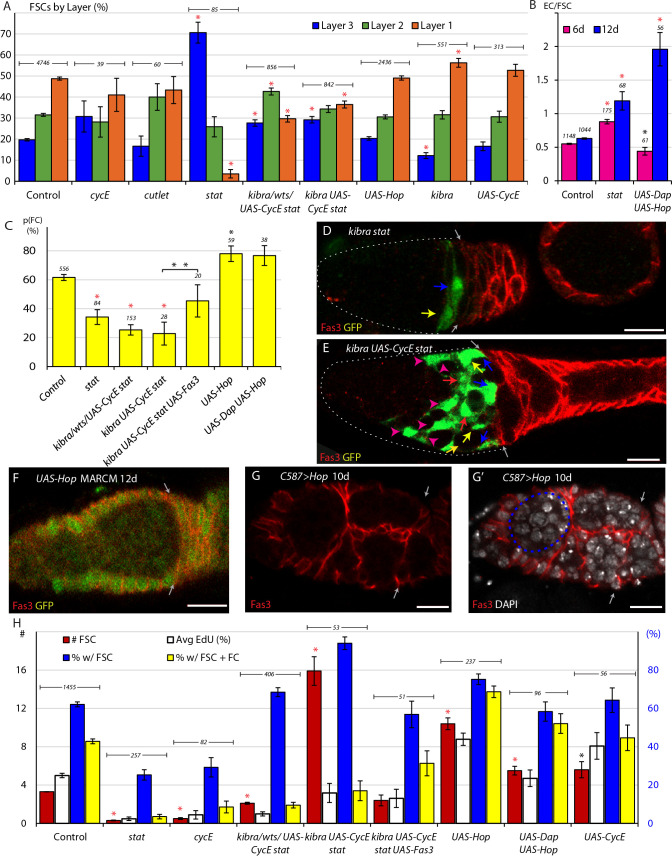
JAK-STAT signaling promotes conversion of FSCs to FCs.(A) Relative frequency of marked FSCs in each layer for the indicated genotypes of MARCM lineages, with the number of total FSCs scored for each genotype and significant differences to control values (red asterisks, p<0.001). Here and elsewhere, ‘kibra/wts/UAS-CycE stat’ is the sum of all tests with kibra stat, wts stat and UAS-CycE stat. (B) ECs produced per anterior FSC from 0-6d (magenta) and 0-12d (blue) for the indicated MARCM lineage genotypes with the total number of relevant germaria scored and significant differences to control values (black asterisk, p<0.05, red asterisks, p<0.001). (C) Average probability of a layer 1 FSC becoming an FC during a single budding cycle for the indicated MARCM lineage genotypes with the number of informative germaria scored and significant differences to control values, or for the bracketed comparison (double asterisks) showing the impact of UAS-Fas3 (black asterisks, p<0.05, red asterisks, p<0.001). (D–E) Despite marked FSCs in layer 1 (blue arrows), and a significant number of layer 2 FSCs (yellow arrows), layer 3 FSCs (red arrows), and ECs (magenta arrowheads), marked FCs, posterior to the Fas3 (red) border (gray arrows) are absent here (and were generally rare) in kibra stat and kibra UAS-CycE stat MARCM lineages. (F–G) Increased JAK-STAT pathway activity induced ectopic anterior Fas3 (red) expression (F) cell autonomously in MARCM lineages (green) and (G–G’) in numerous cells anterior to the normal Fas3 border (arrows) when increased throughout the anterior germarium using C587-GAL4, sometimes partitioning single cysts, visualized by DAPI (white) nuclear staining, into egg chamber-like structures (dashed blue line). (H) Number of FSCs per germarium (red) using y-axis scale on the left, percentage of FSCs incorporating EdU (aggregating all layers, white), percentage of ovarioles with a marked FSC (blue) and percentage of ovarioles with a marked FSC and marked FCs (yellow) (percentage y-axis scale in blue on the right) for the indicated genotypes, with the number of germaria scored at 12d (EdU was scored at 6d with n reported in (A)) and significant differences for FSC numbers compared to control values (black asterisks, p<0.05, red asterisks, p<0.001). All scale bars are 10 μm.Figure 3—source data 1.Numerical data for graphs in Figure 3.